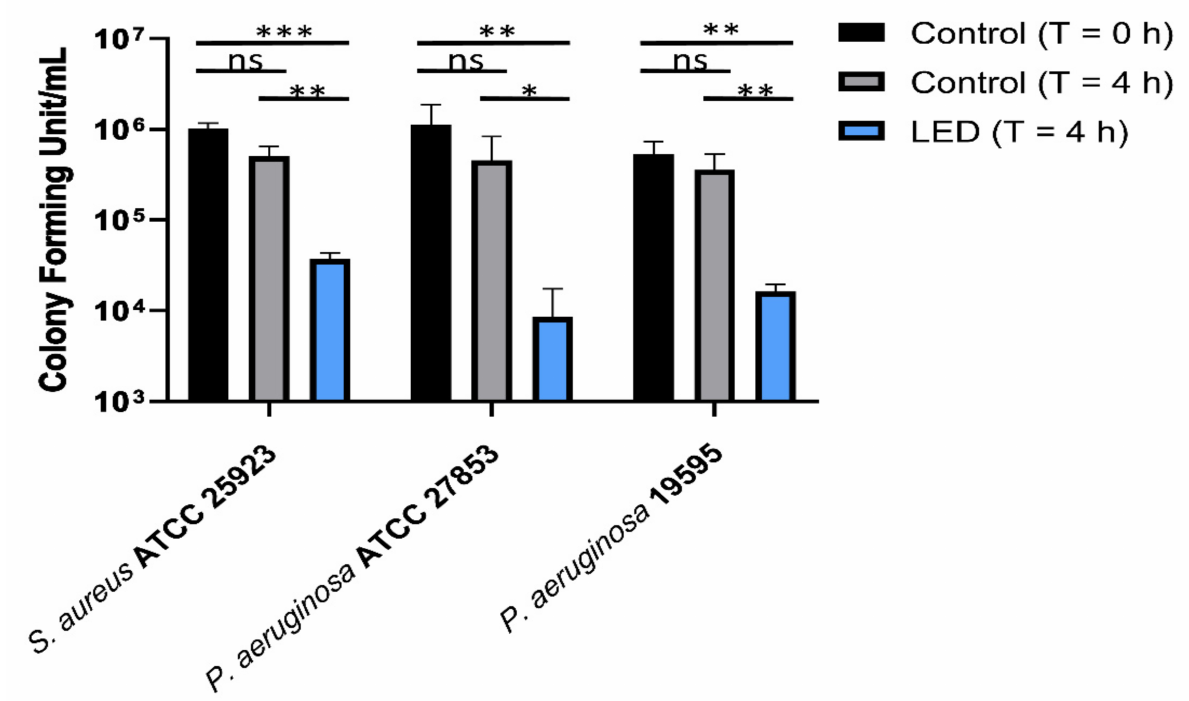
Figure 1. Number of viable cells of S. aureus ATCC 25923, P. aeruginosa ATCC 27853 and the clinical isolate P. aeruginosa 19595, after 4 h of treatment with b-LED (blue bars). Controls were untreated samples at time 0 (black bars) and 4 h (grey bars). The data reported are the mean ± standard deviation (SD) of three independent experiments. The level of statistical significance between samples was determined by the multiple t test (GraphPad Prism v.8.0.1, GraphPad Software, La Jolla, CA, USA), and indicated as follows: * p < 0.05; ** p < 0.01; *** p < 0.001 and ns, not